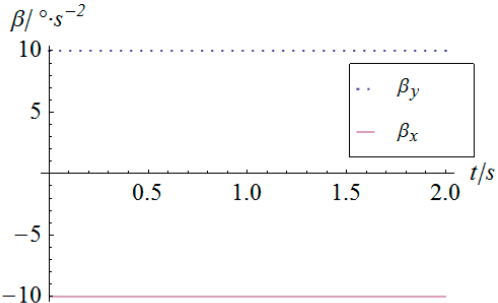
Figure 7. Angular acceleration vs. time of the mobile platform.